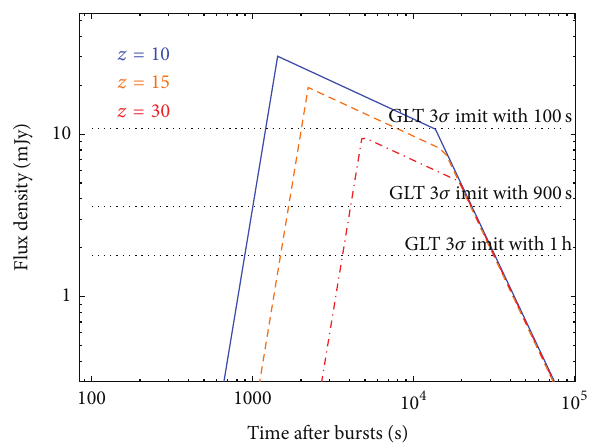
Figure 9: Expected light curves of GRB afterglows at 𝑧 = 10 , 15, and 30 at 230 GHz. Other physical parameters are fixed as 𝐸 = 1 × 10 53 , = 0.3 , 𝜖 = 0.03 , and 𝜖 = 0.01 . The expected Γ = 80 , 𝑛 = 1 , 𝜖 𝑒 𝐵, RS 𝐵, FS GLT 3- 𝜎 limits with 900 s and 1h exposure are indicated with dotted lines. GLT with rapid follow-ups has sufficient potential to detect these higher- 𝑧